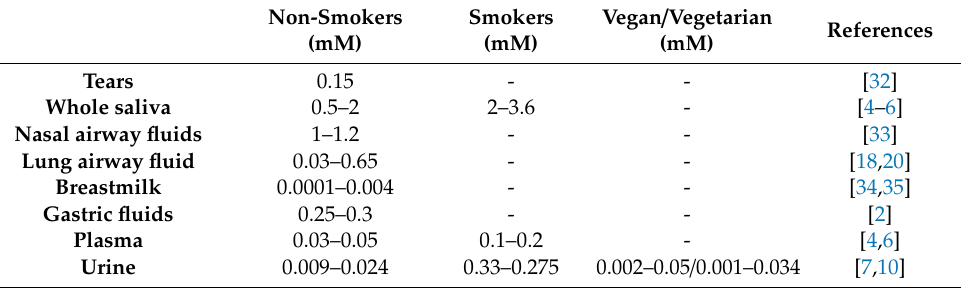
Table 1. Ranges of SCN − concentration in various human biological